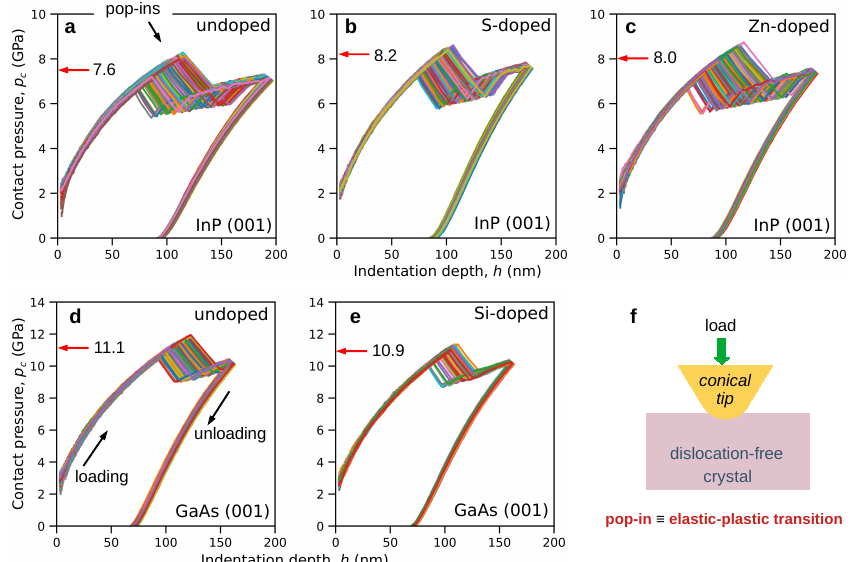
Figure 4. Results of nanoindentation experiments on the ( 001 ) InP surface: p c − h curves obtained for undoped ( a ) S- ( b ) and Zn-doped ( c ) crystals [14]. The red arrow assisted by the number indicates the mean contact pressure. Doping of InP shifts the mean contact pressure distribution towards higher values. In contrast, Si-doping of GaAs causes a decrease in the contact pressure ( d , e ). The last panel ( f ) presents a schematic of a nanoindentation